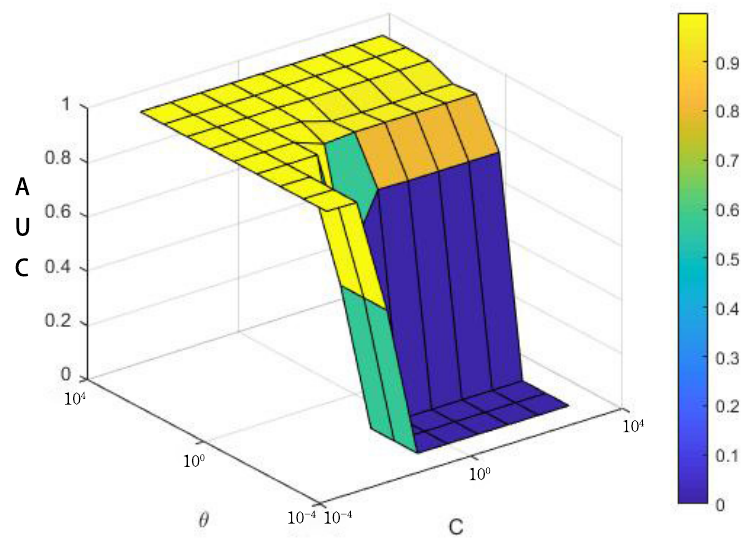
Figure 9. Tuning C and θ of the proposed LRSNCR in the ABU-urban